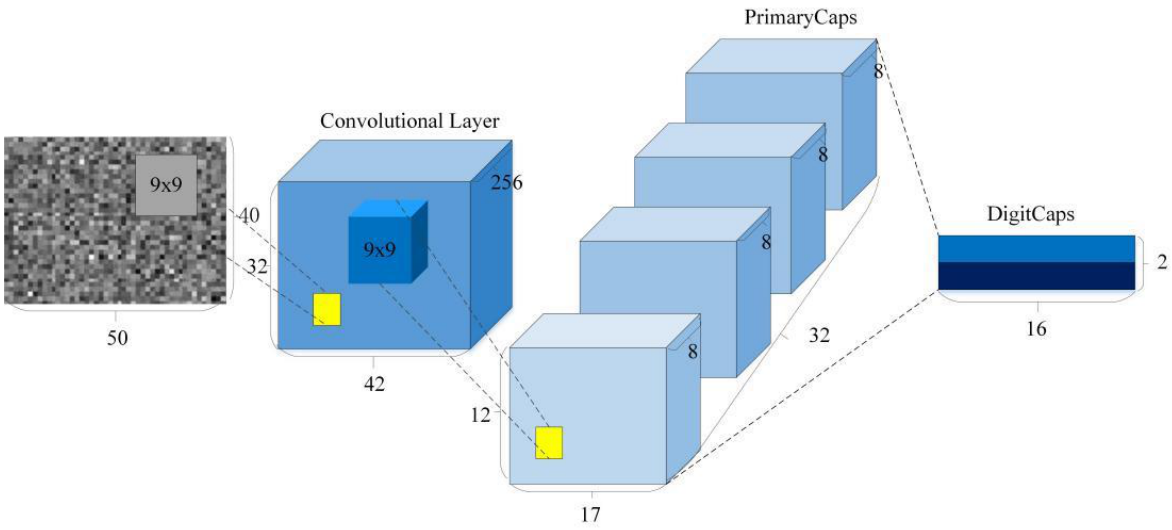
Figure 2. The architecture of CapsNet.